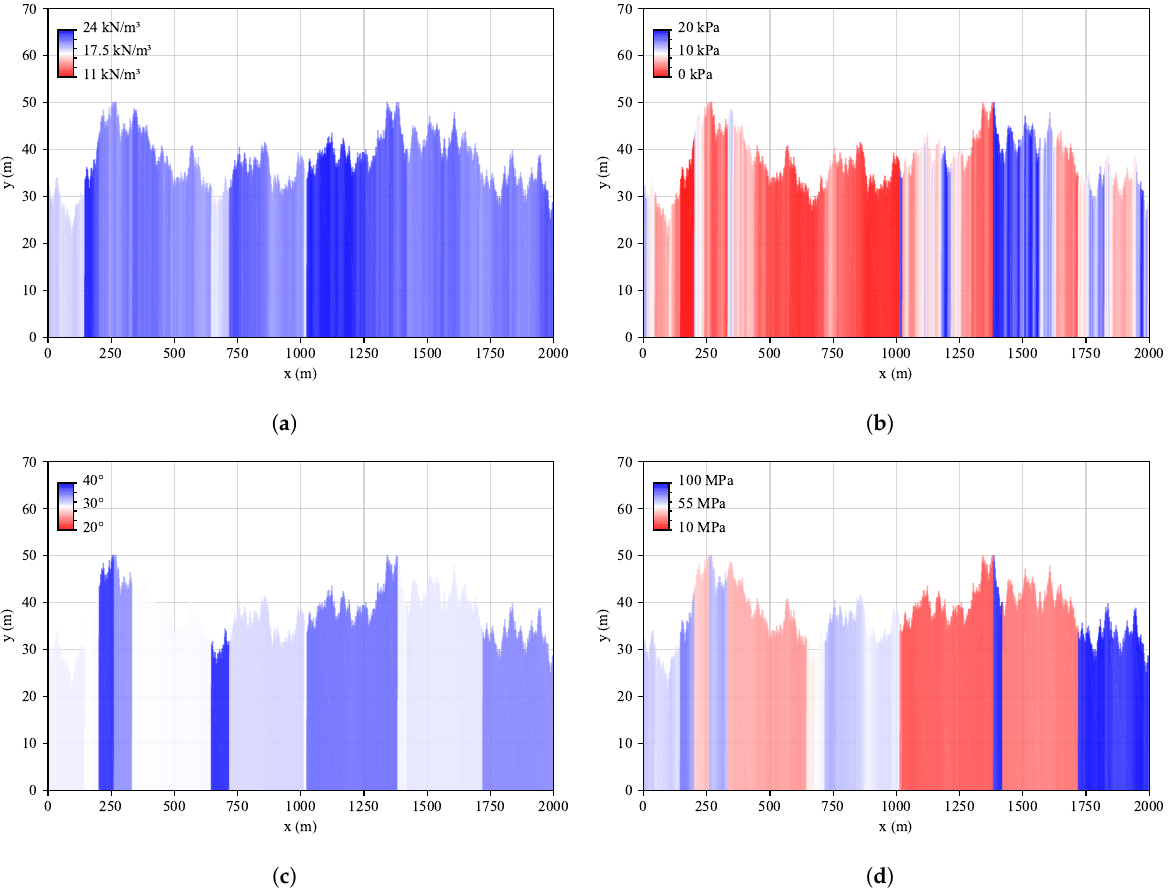
Figure 1. Random soil property values of the analytical environment with constant geology: ( a ) Unit soil weight. ( b ) Cohesion. ( c ) Friction angle. ( d ) Young’s